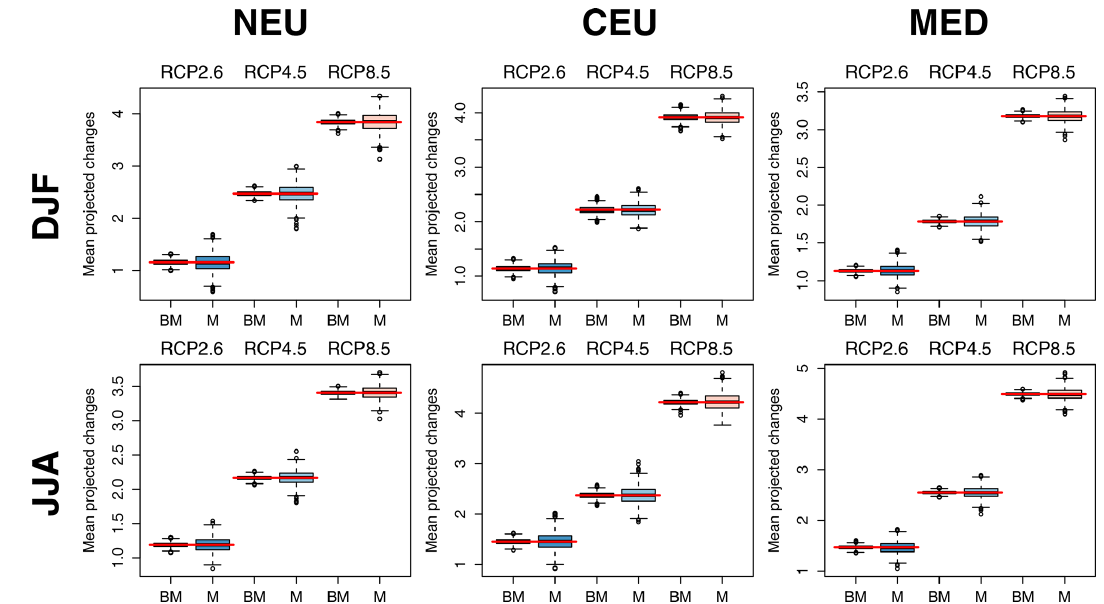
Figure 14. Comparison of mean projected changes estimates for temperature using QUALYPSO (BM) and direct averages ( M ) of a synthetic MME for each RCP scenario, SREX region, and season. A complete synthetic MME composed of 9 GCMs × 13 RCMs × 3 RCPs = 351 chains is generated using the ANOVA effects and the residual variability estimated with the original MME. Each box plot shows the distri- bution of the 1000 mean change estimates obtained with the 1000 incomplete MMEs (87 chains) randomly subsampled from the complete synthetic MME (351 chains). Each incomplete MME includes at least one chain for each of the 9 GCMs, 13 RCMs, and 3 RCPs. Red horizontal lines indicate the corresponding averages obtained from the complete MME.